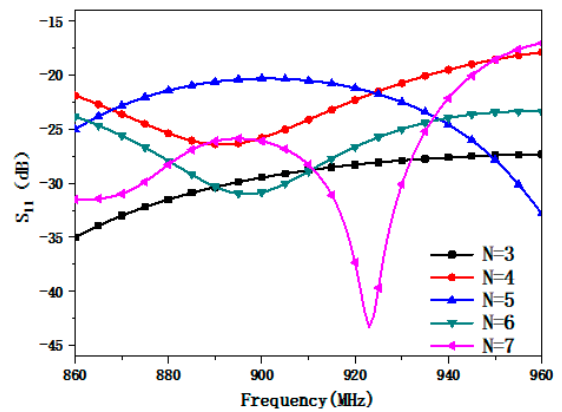
Figure 9. Simulated reflection coefficient S11 with different numbers of spiral loops in the antenna.